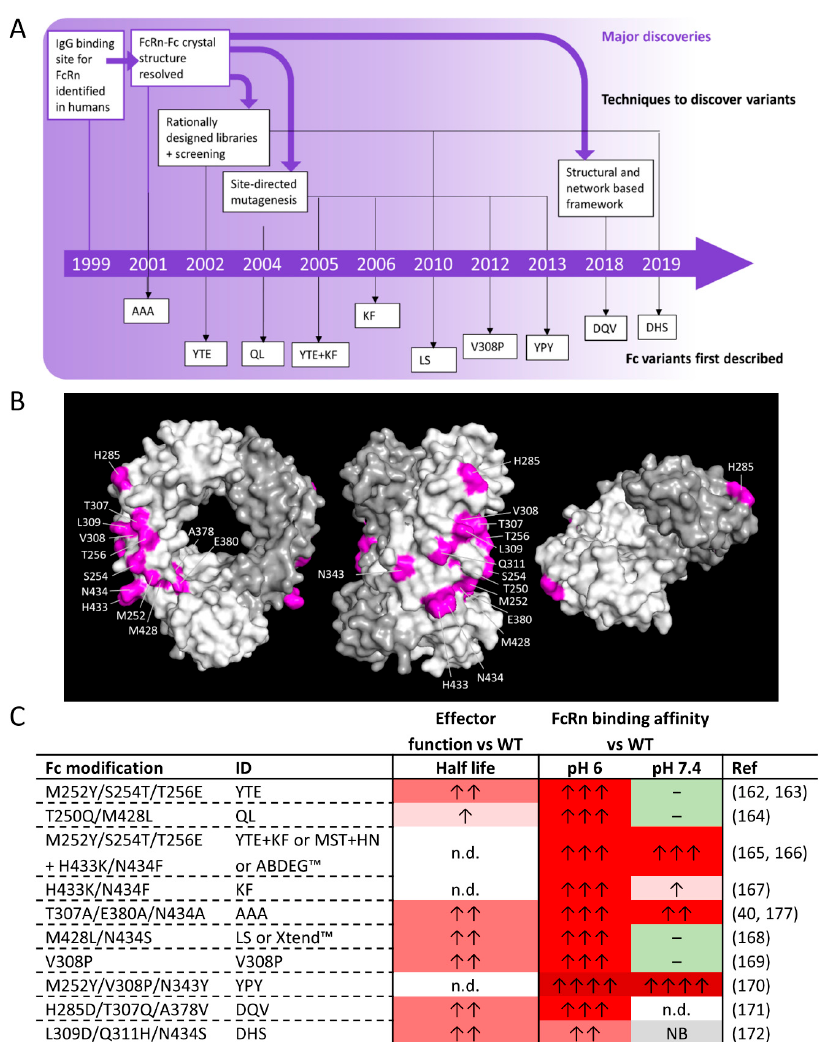
Figure 5. Fc modifications that improve half-life. ( A ) Timeline of events detailing when major discoveries were made regarding Fc:IgG interactions, techniques used to discover variants that have enhanced half-life and when the Fc variants were first described in the literature [40,162–172,177]. Letters refer to the common notation of the introduced amino acid substitutions as discussed in the main text. ( B ) Previously identified point mutations within the Fc that impact effector cell function annotated on a hIgG1 Fc crystal structure model (PDB: 3AVE; [49,50]) and detailed in the table below. ( C ) Magnitude of change to half-life or binding affinity for FcRn of variants were compared to WT antibodies of the same IgG isotype and F(ab) region. Each row depicts an independent experiment and therefore often independent methods, utilizing a different IgG backbone from a particular study as referenced in the last column. NB—no detectable binding, n.d.—no data, − no change, ↑ < 2 fold